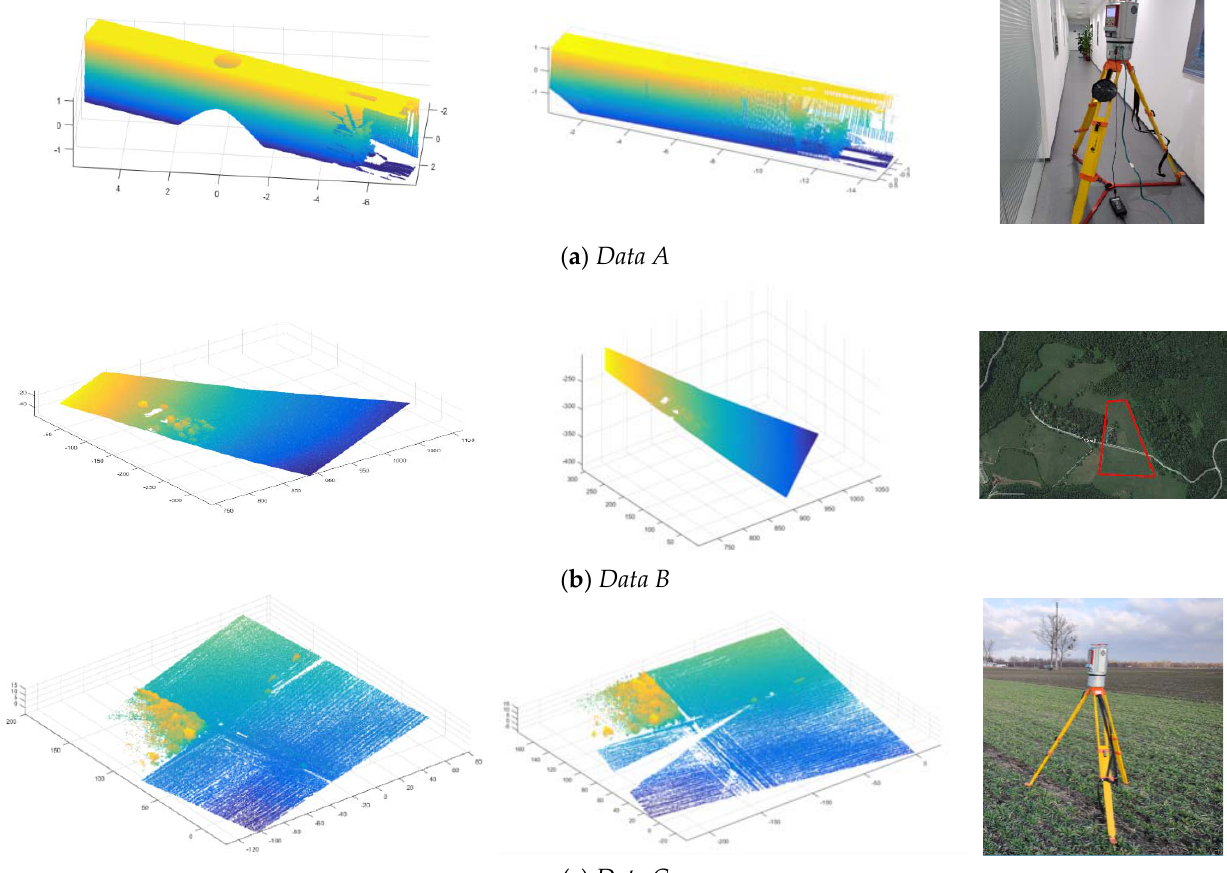
Figure 8. Demonstration of a scan of the data